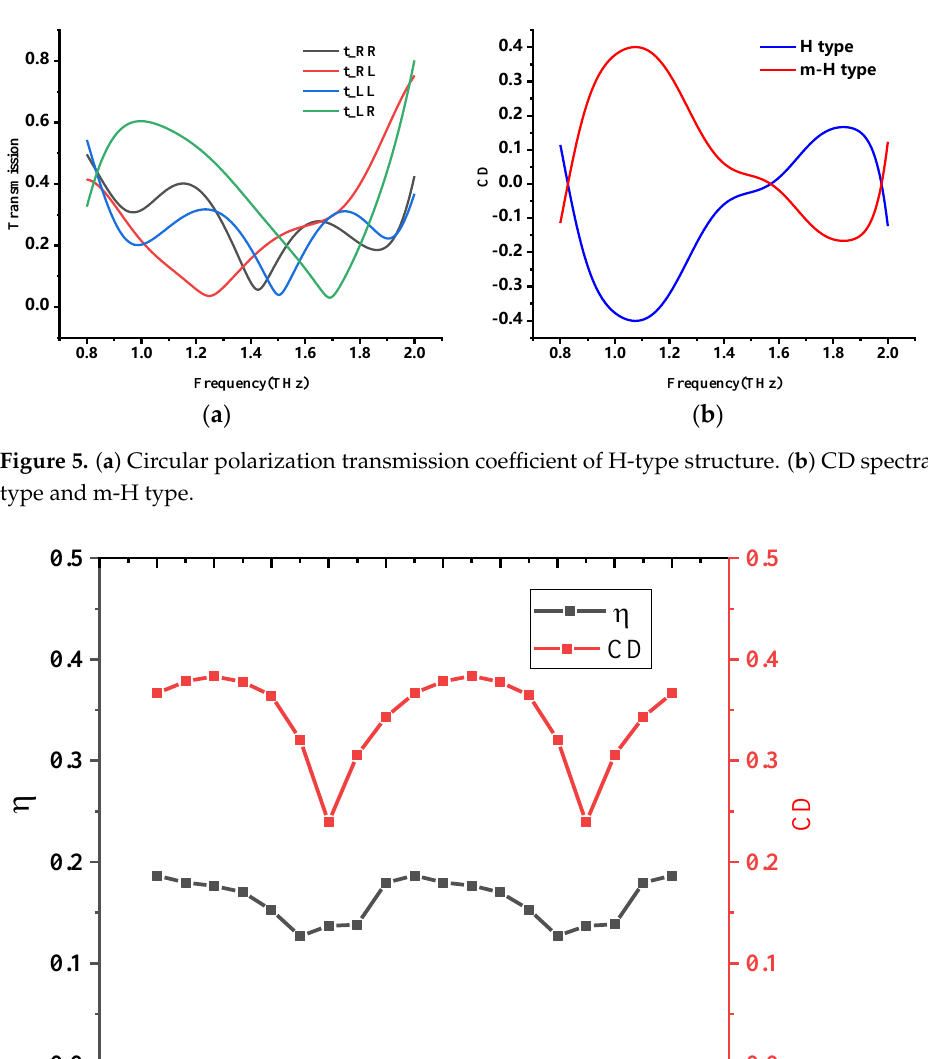
( b ) Figure 7. ( a ) The configuration of HN letters. ( b ) Cross-polarization and co-polarization images un- der LCP and RCP incidence. The detection probe is located at 200 μm from the array surface.